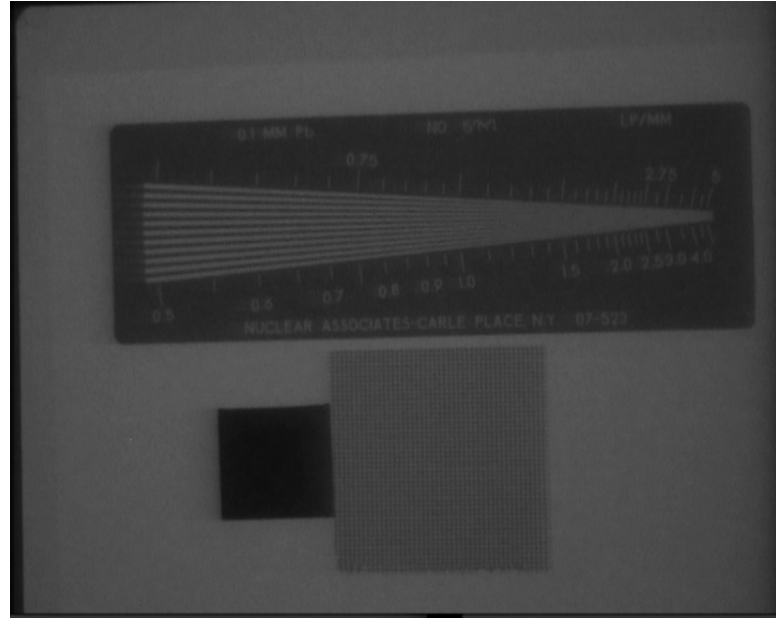
Figure 9. Resolution test of x-ray dectetor. 1.2 lp/mm is observed.